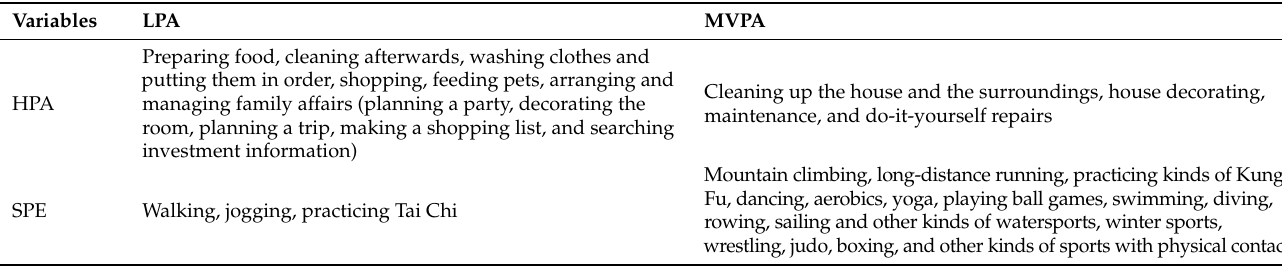
Table 1. HPA and SPE assessments by